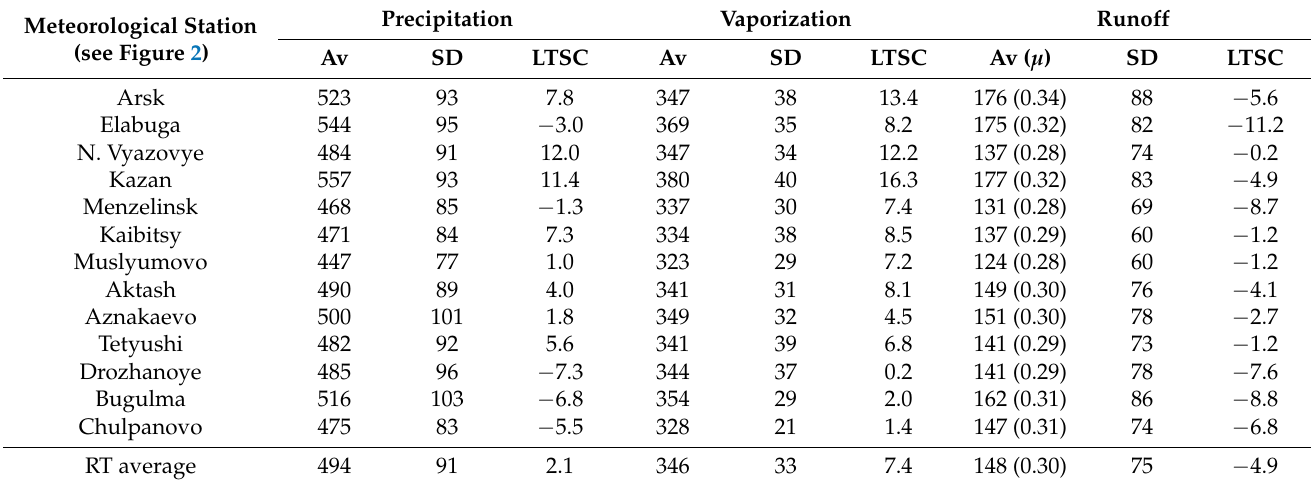
Table 6. Spatial distribution of some hydrometeorological variables indicators (annual values) in the Republic of Tatarstan (RT), the Volga Federal District, during 1966–2021.